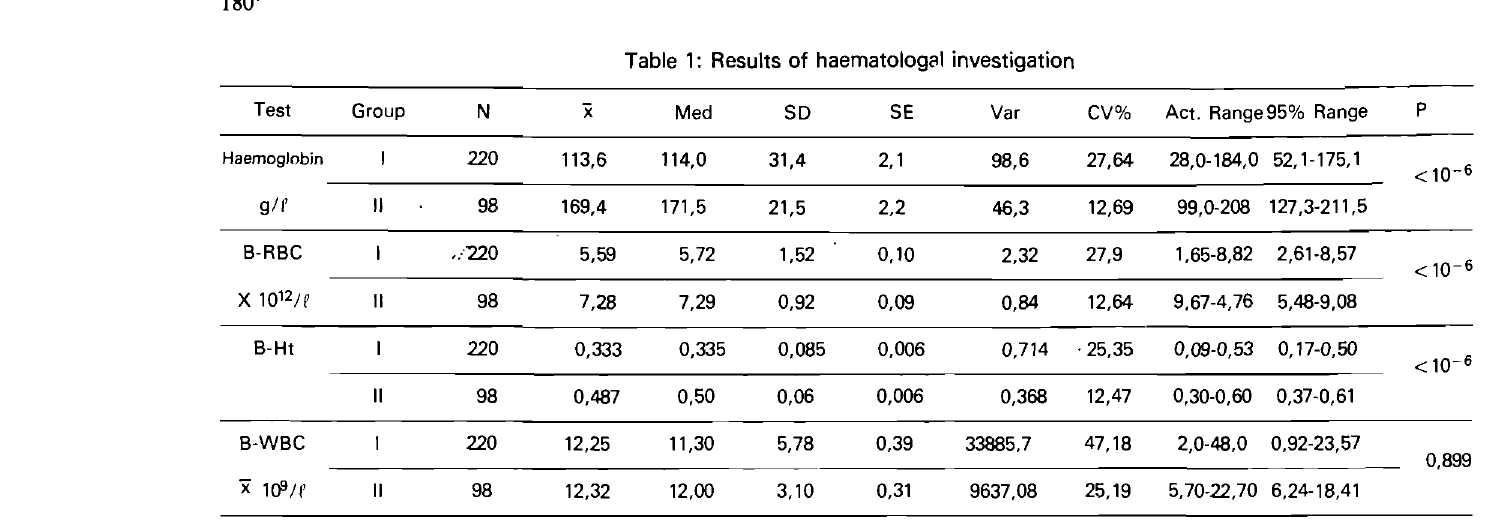
Table 1: Results of haematologal